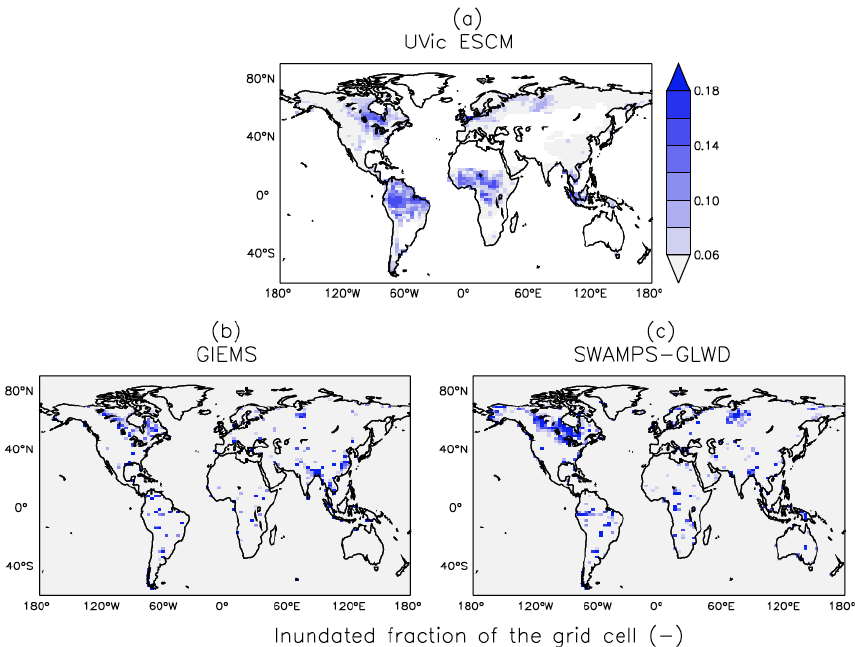
Figure 5. Average wetland extents (inundated fractions of grid cells) across the globe over the 2000–2007 period as simulated by the UVic ESCM (a) in comparison to two datasets: (b) GIEMS and (c) SWAMPS-GLWD. The datasets are regridded to 3.6 ◦ × 1.8 ◦ for a fair comparison with the UVic ESCM. The comparison period corresponds to the overlap period for the two datasets.